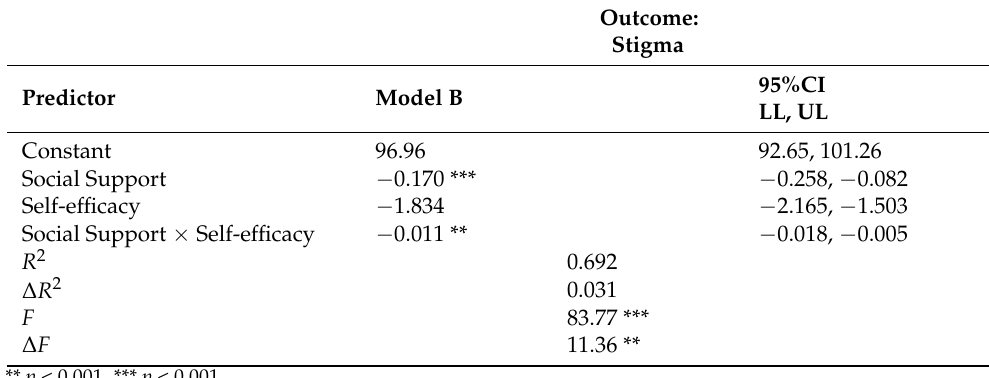
Table 4. Multiple Regression Analysis for the moderating role of Self-Efficacy within the relationship between Social Support and Stigma (N = 116).